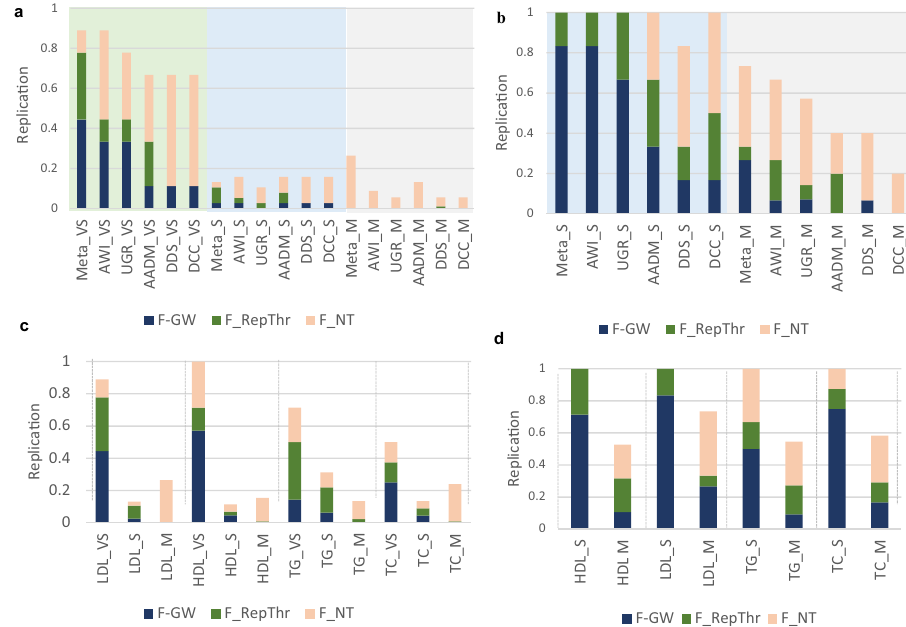
Fig. 4 Transferability of previous lipid-trait associations to various African GWASs. a LDL-C association signals detected in the Global Lipid Genetics Consortium (GLGC) 15 study. b LDL-C association signals detected in Population Architecture using Genomics and Epidemiology Consortium (PAGE) 36 study. The Y -axis shows the proportion of associated loci that are replicated in each of the individual African studies. The proportion of signals replicated at the genome-wide signi fi cance threshold P -value < 5 × 10 − 8 are shown in deep blue (F-GW), at P -value < 5 × 10 − 4 are shown in dark green (F_RepThr) and at the nominal threshold of P -value < 0.05 are shown in orange (F_NT). The signals from the GLGC study were partitioned on the basis of signal strength into Very Strong ( P -value < 10 − 100 ) indicated by the suf fi x “ _VS ” and a green background, Strong (10 − 20 > P -value > 10 − 100 ) indicated by the suf fi x “ _S ” and a blue background, and moderate (5 × 10 − 8 > P -value > 10 − 20 ) indicated by the suf fi x “ _M ” and a grey background. For the PAGE study only two categories, Strong (S) ( P -value < 10 − 20 ) and Moderate (M) (5 × 10 − 8 > P -value > 10 − 20 ) were considered. The African replication datasets used in the analysis are – Stage 2 GWAS (Meta-analysis) ( N = 23,718), Stage 1 GWAS (AWI-Gen) ( N = 10,603), Uganda Genome Resource (UGR) study ( N = 6407), Africa-America Diabetes Mellitus (AADM) study ( N = 4116), Durban Diabetes study (DDS) ( N = 1117) and Durban case control (DCC) study ( N = 1475). Comparison of transferability of signals from c GLGC Consortium study, d PAGE Consortium study in the Stage 2 GWAS results for each of the four lipid traits are